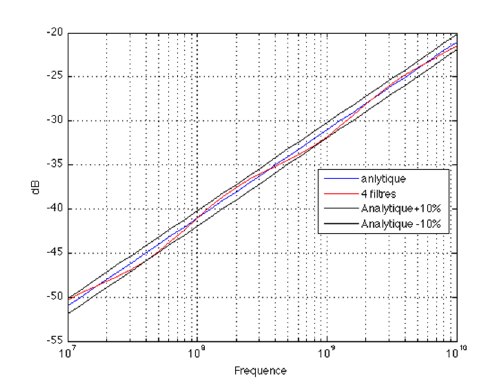
Figure 7. Fitting of the surface impedance and approximation error.